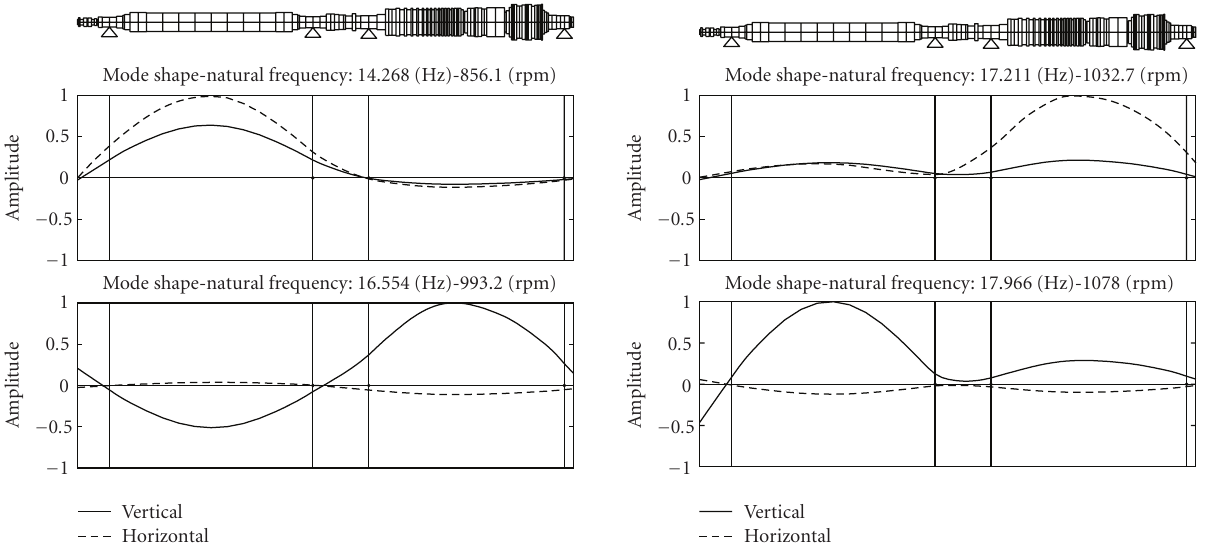
Figure 9: Mode shapes of the shaft-train associated with the first four eigenfrequencies evaluated by means of the model no. 2.